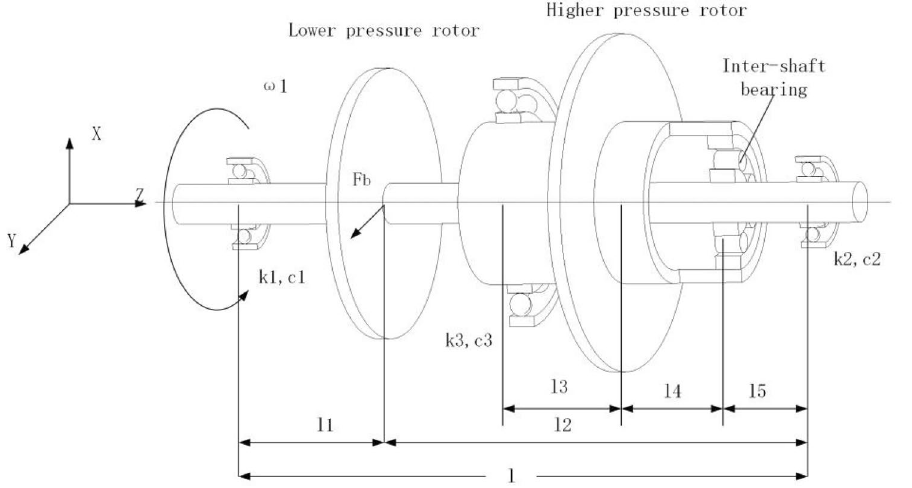
Figure 1. Schematic diagram of a typical dual-rotor